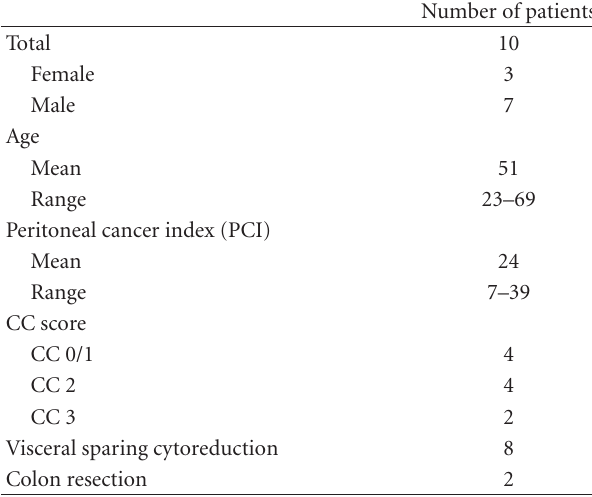
Table 1: Demographic features and outcomes of cytoreductive surgery in ten patients undergoing adjuvant chemotherapy with intraperitoneal pemetrexed and intravenous cisplatin for di ff use malignant peritoneal mesothelioma.